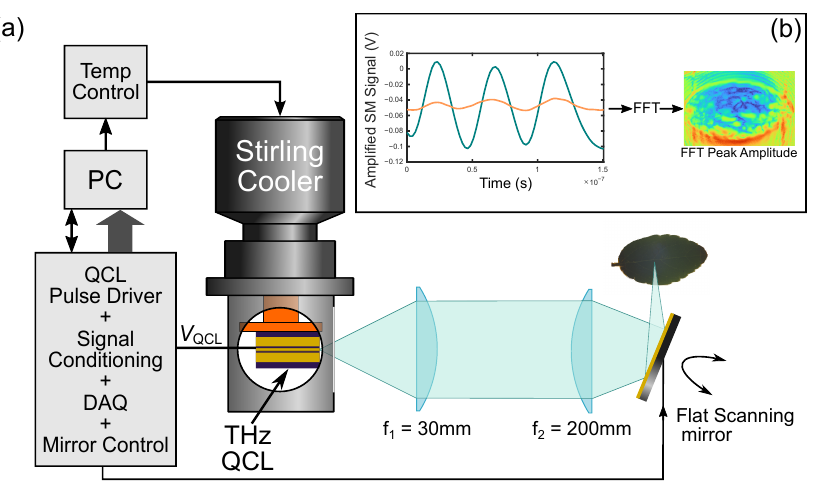
Figure 5. ( a ) Schematic of THz QCL LFI imaging setup showing fast scanning imaging mode. ( b ) Processing steps of the LFI interferogram (amplified self-mixing (SM) signal) into image pixels. Blue trace shows signal off bare metal backing. Orange trace shows representative signal from the